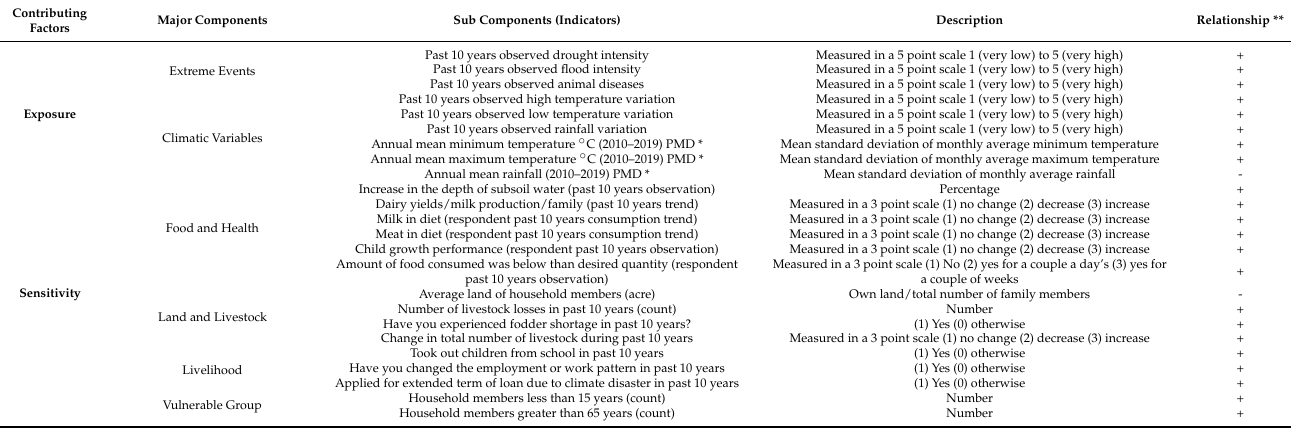
Table 4. Vulnerability indicators (major components and sub-components) and functional relationship with